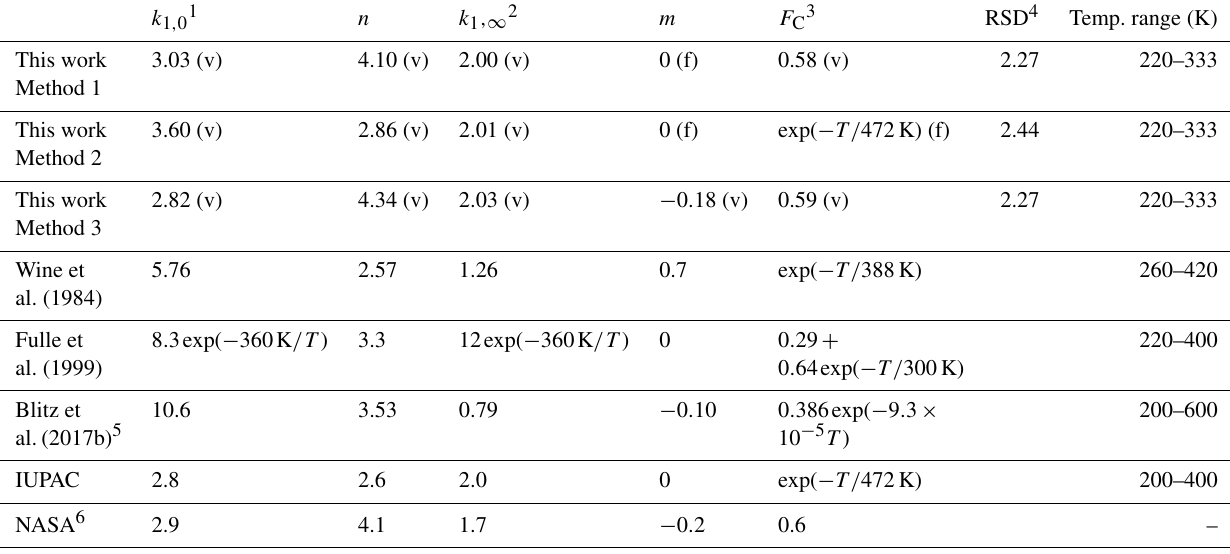
Table 2. Parameterization of k 1 in N 2